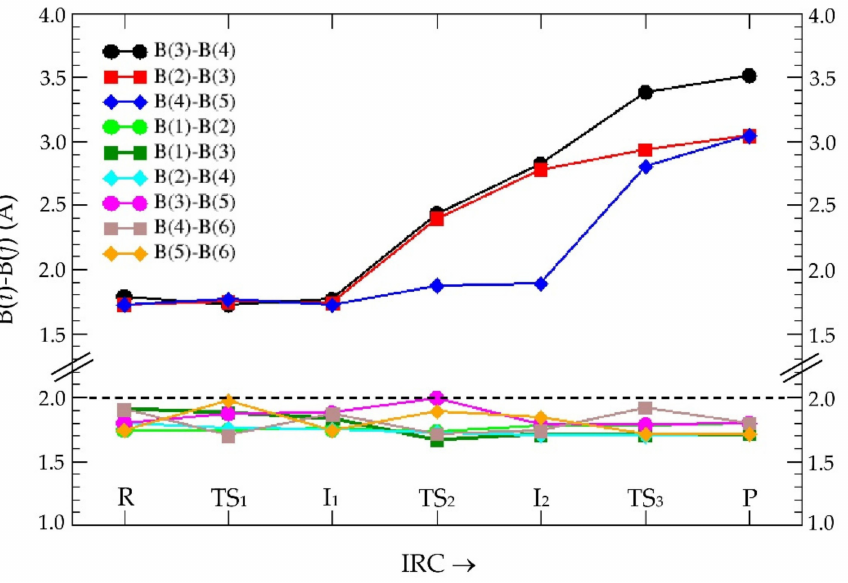
Figure 3. B( i )-B( j ) distances (Å) for the Stationary Points (SP) along the R → P reaction pathway for the 3D → 2D isomerization of hexaborane(12).